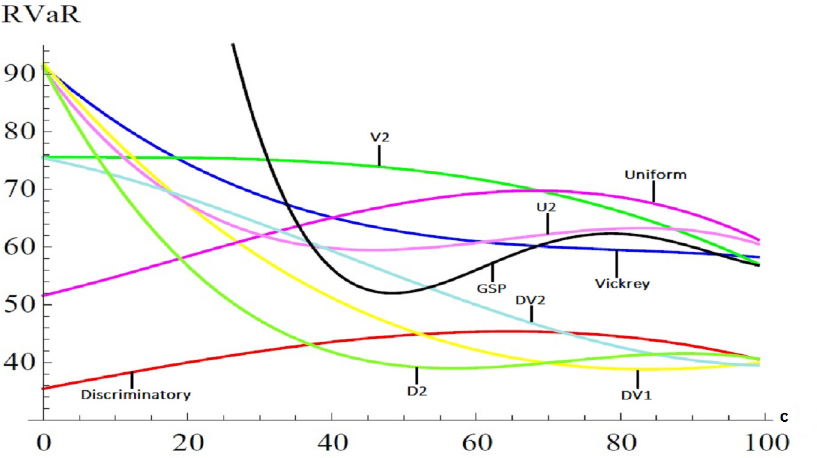
Figure 4. RVaR 0.95 of the eight auctions mechanisms of the parametric family corresponding to the vertices and GSP with 3 objects and 4